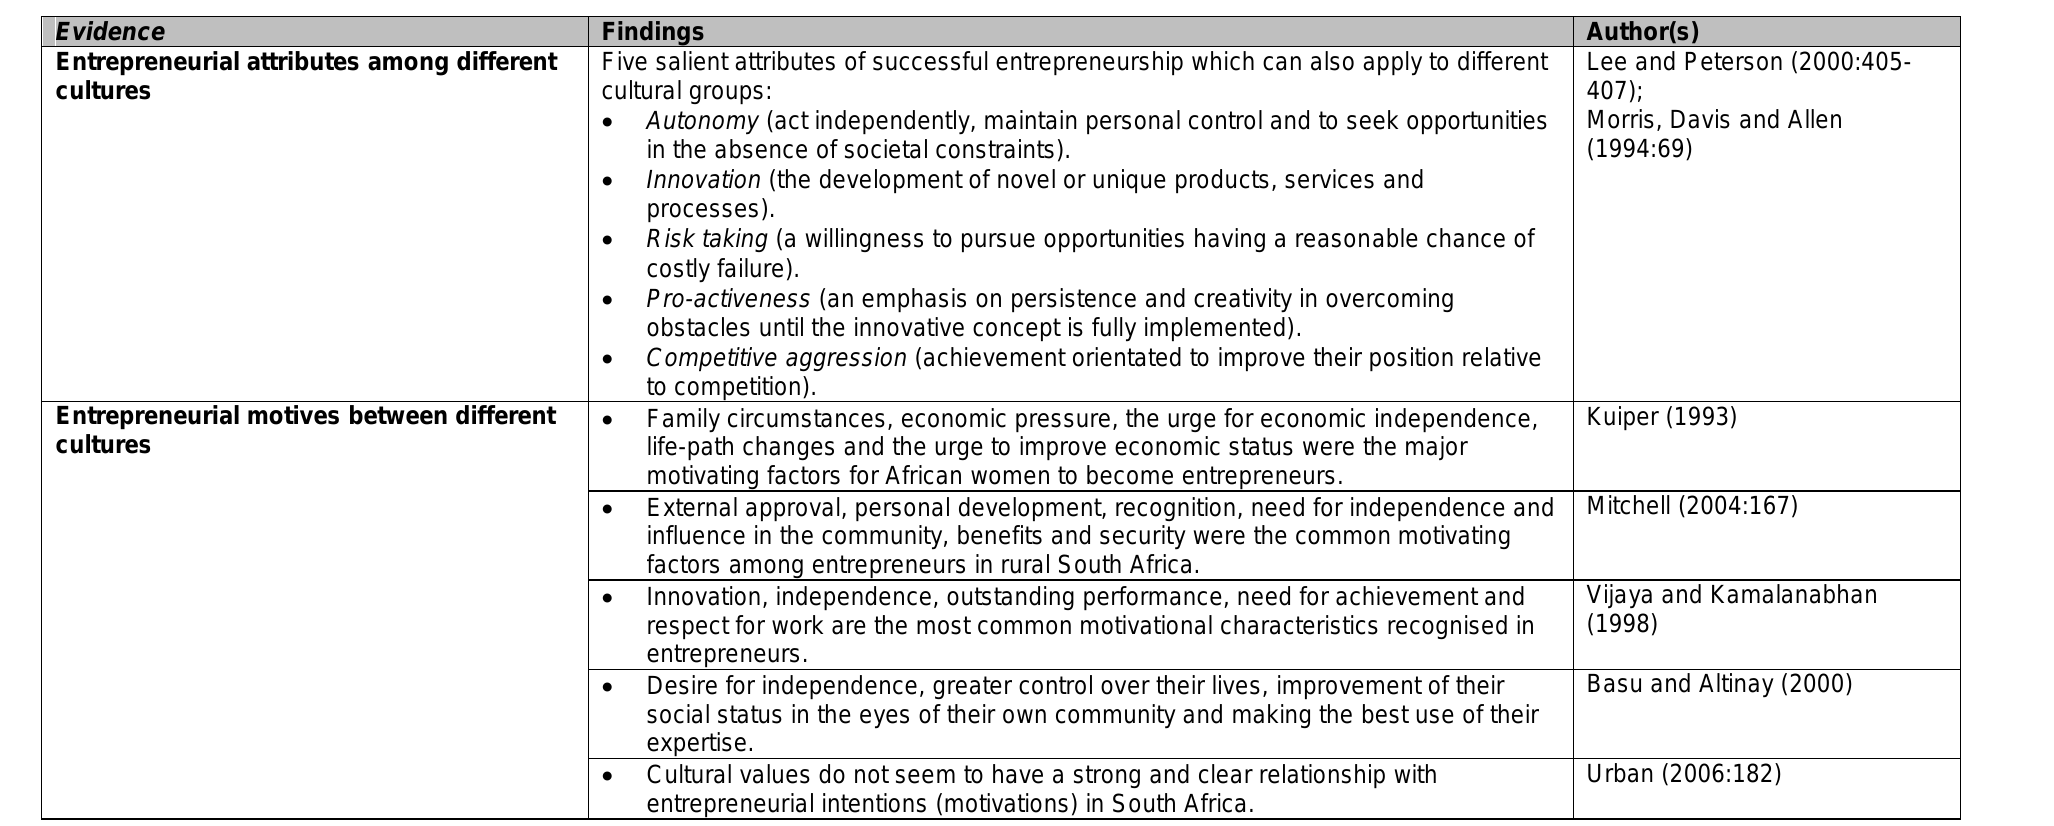
Table 2: The influence of culture on entrepreneurial evidence